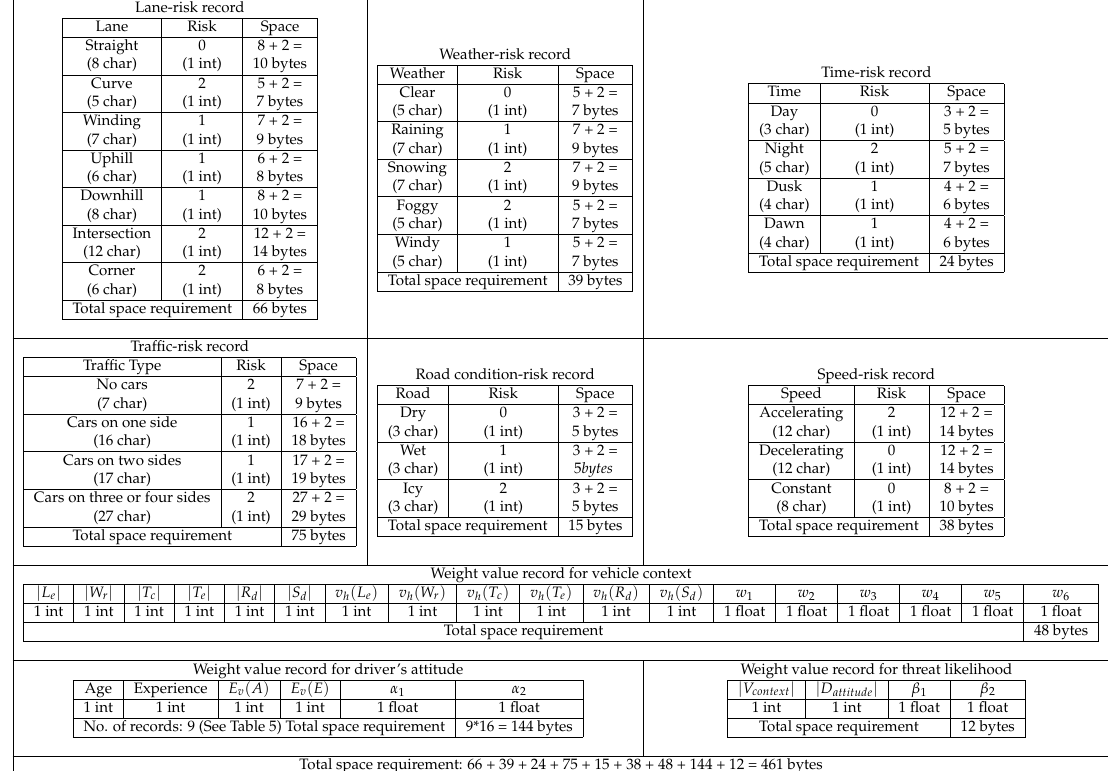
Table 10. Space requirement of the proposed scheme.